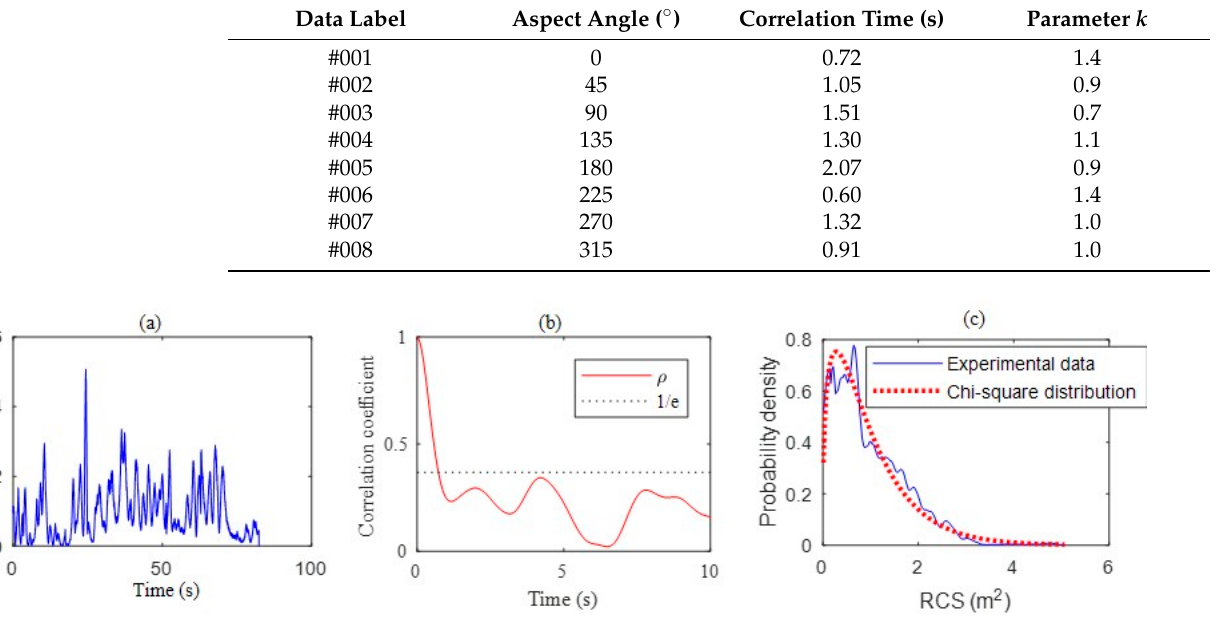
Table 3. Target RCS fluctuation characterizations from eight aspect angles.